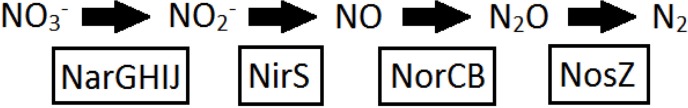
Denitrification pathway. Reduction of nitrate to nitrite, nitric oxide, nitrous oxide, and finally dinitrogen. The four reductase enzymes nitrate reductase, nitrite reductase, nitric oxide reductase, and nitrous oxide reduction are boxed below. Nitrite reduction marks the first step of strict denitrification.